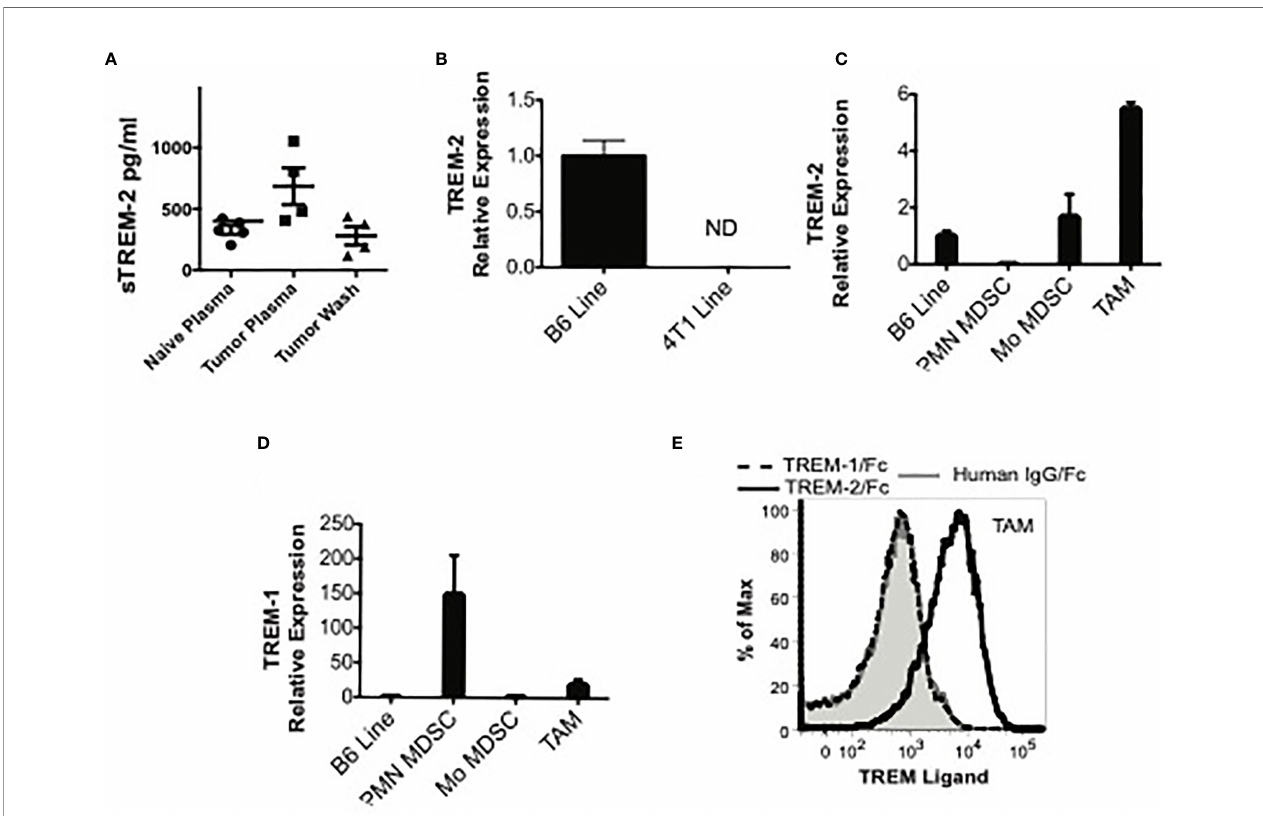
FIGURE 3 | TREM-2 is expressed in monocytic MDSC (Mo-MDSC) and tumor-associated macrophages (TAM), and a possible ligand is expressed in TAM. (A) sTREM- 2 levels in the plasma of naïve, 4TI-bearing mice or in the wash of 4T1 excised tumors. (B, C) Trem2 expression by qPCR in B6 macrophages, 4T1 cells, splenic MDSC, or TAM as indicated. (B) Relative Trem2 mRNA expression in B6 macrophages compared to 4TI cells demonstrating a neglectable Trem1 expression in tumor cells. (C, D) Relative Trem2 and Trem1 mRNA expression in sorted splenic PMN-MDSC, Mo-MDSC, or TAM sorted from 4T1 tumors removed from mice (see Supplementary Figures S2 – S4 for the gating strategy). Data are normalized to a Trem1 - and Trem2 -expressing macrophage cell line (B6 Line). (E) Single-cell suspensions from 4T1 tumors from tumor-bearing mice were stained with MDSC markers and human (hu) IgG-Fc (gray shaded), TREM-1/hu IgG-Fc (dashed line), or TREM-2/hu IgG-Fc (solid line, no shading), followed by PE-labeled anti-human IgG-Fc. The TREM/hu IgG-Fc expression is shown on gated Gr-1 - CD11b +